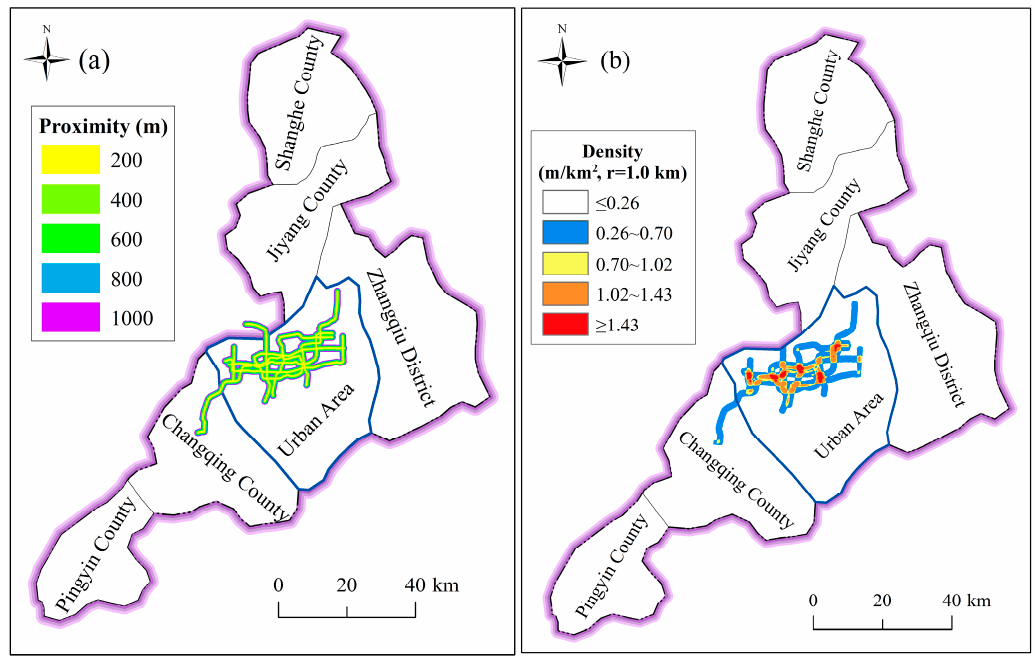
Figure 13. Spatial distribution of metro line proximity and density: ( a ) proximity; and ( b ) density.